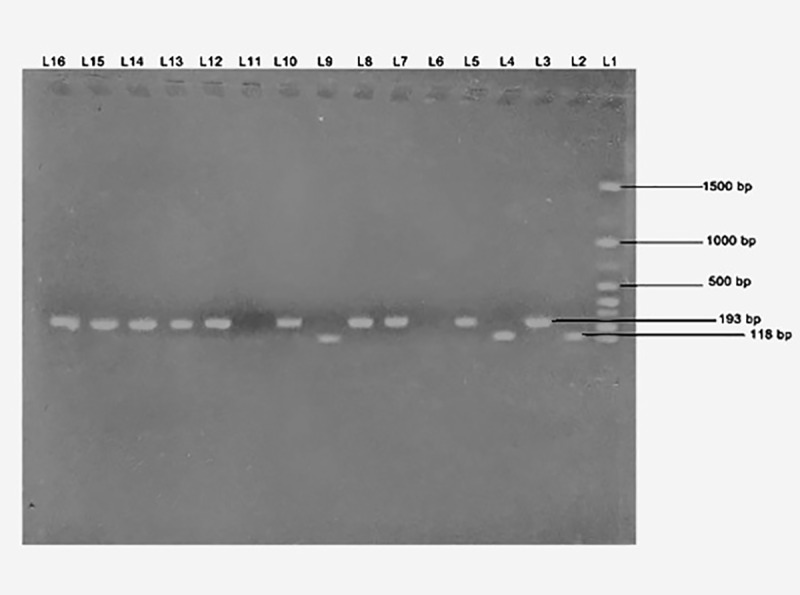
Agarose gel electrophoresis of amplified SEN virus D- and H-gene DNA.Bands showing the presence of SEN virus D (193 bp) and H (118 bp) genes in lanes L5, L10, and L15. DNA molecular weight markers (100–1500 bp) are present in lane L1.